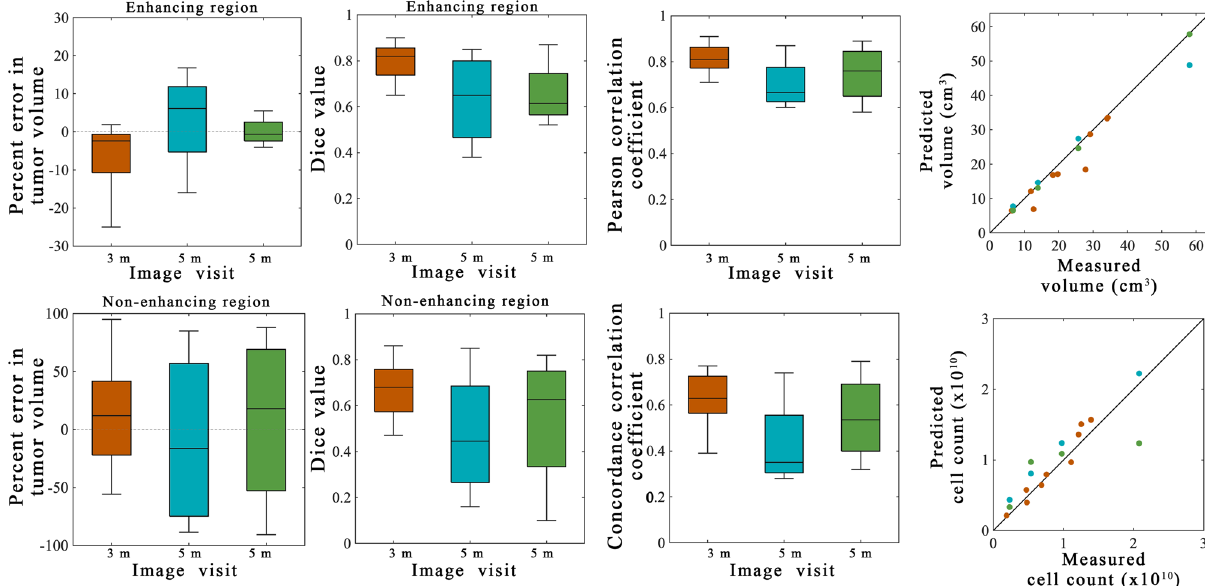
Figure 6. Summary statistics from scenarios 2 and 3. Error analysis from the model prediction scenarios are shown for the entire cohort. The orange bars and points represent 3-month predictions made from calibrations using the 1-month visit for calibration (scenario 2). The blue bars and points represent 5-month predictions made from calibrations using the 1-month visit for calibration (scenario 2). The green bars and points represent 5-month predictions made from calibrations using the 1-month and 3-month visits for calibration (scenario 3). The left column shows the percent error in the tumor volume for the enhancing (top) and non-enhancing (bottom) regions. Greater error was observed in the non-enhancing regions versus the enhancing regions. The second column shows the Dice values for the enhancing (top) and non-enhancing (bottom) regions. A high level of overlap (median Dice values greater than 0.62) were observed for the enhancing regions while the non-enhancing regions had greater error (Dice greater than 0.45). The third column shows the results of the voxel-level error analysis for the PCC (top) and CCC (bottom). The fourth column shows the predicted versus measured tumor volume (top) and cell count (bottom) within the enhancing region. For the 3-month predictions (orange dots) KCCs for tumor volume and cell count predictions were 0.94 and 0.92, respectively. For the 5-month predictions (blue dots) the KCCs for tumor volume and cell count predictions were 1.00 and 0.88, respectively. For the 5-month predictions (blue dots) the KCCs for tumor volume and cell count predictions were 1.00 and 0.79, respectively. MATLAB R2019b (Mathworks, Natick, MA) was used for producing individual figures, images, and graphs. Adobe Photoshop 2020 (Adobe, San Jose, CA) was used to arrange individual panels, draw schematics, and add